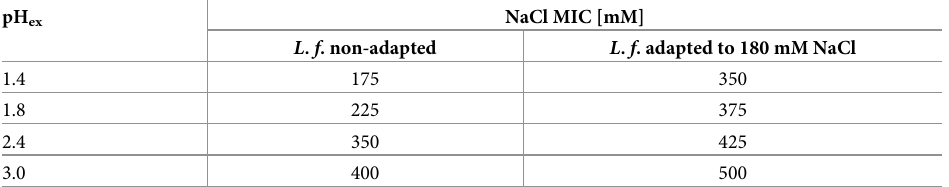
Table 1. Minimum inhibitory concentration of NaCl in L . ferriphilum DSM 14647 adapted to 180 mM NaCl at dif- ferent external pH (pH ex